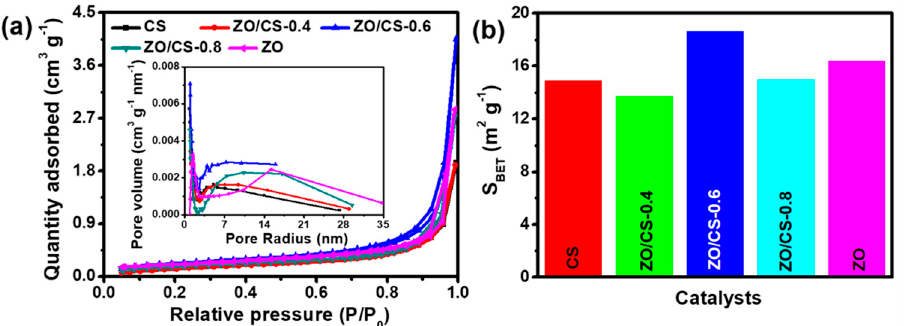
Figure 6. ( a ) N 2 adsorption–desorption isotherms of ZO, ZO/CS nanocomposites, and CS, inserts are the pore size distribution curves; ( b ) BET surface area for the above samples.